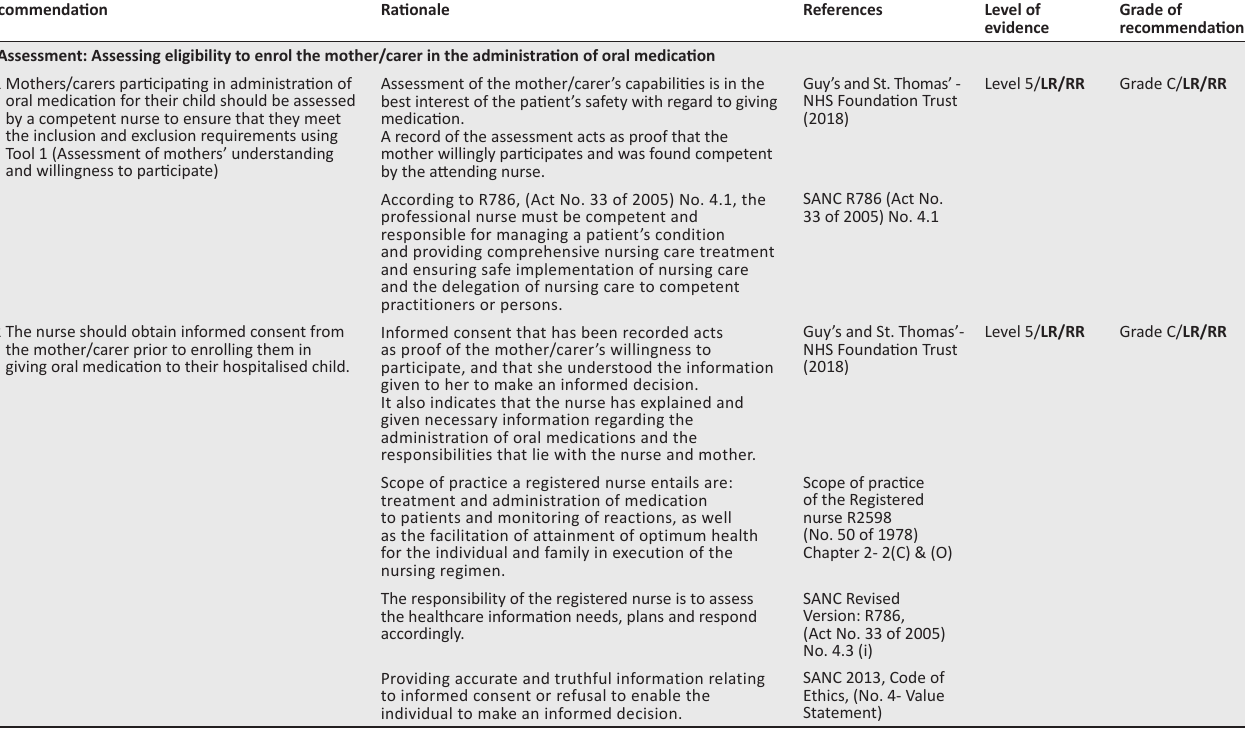
TABLE 2: Recommendations with level of evidence and grade of recommendation.